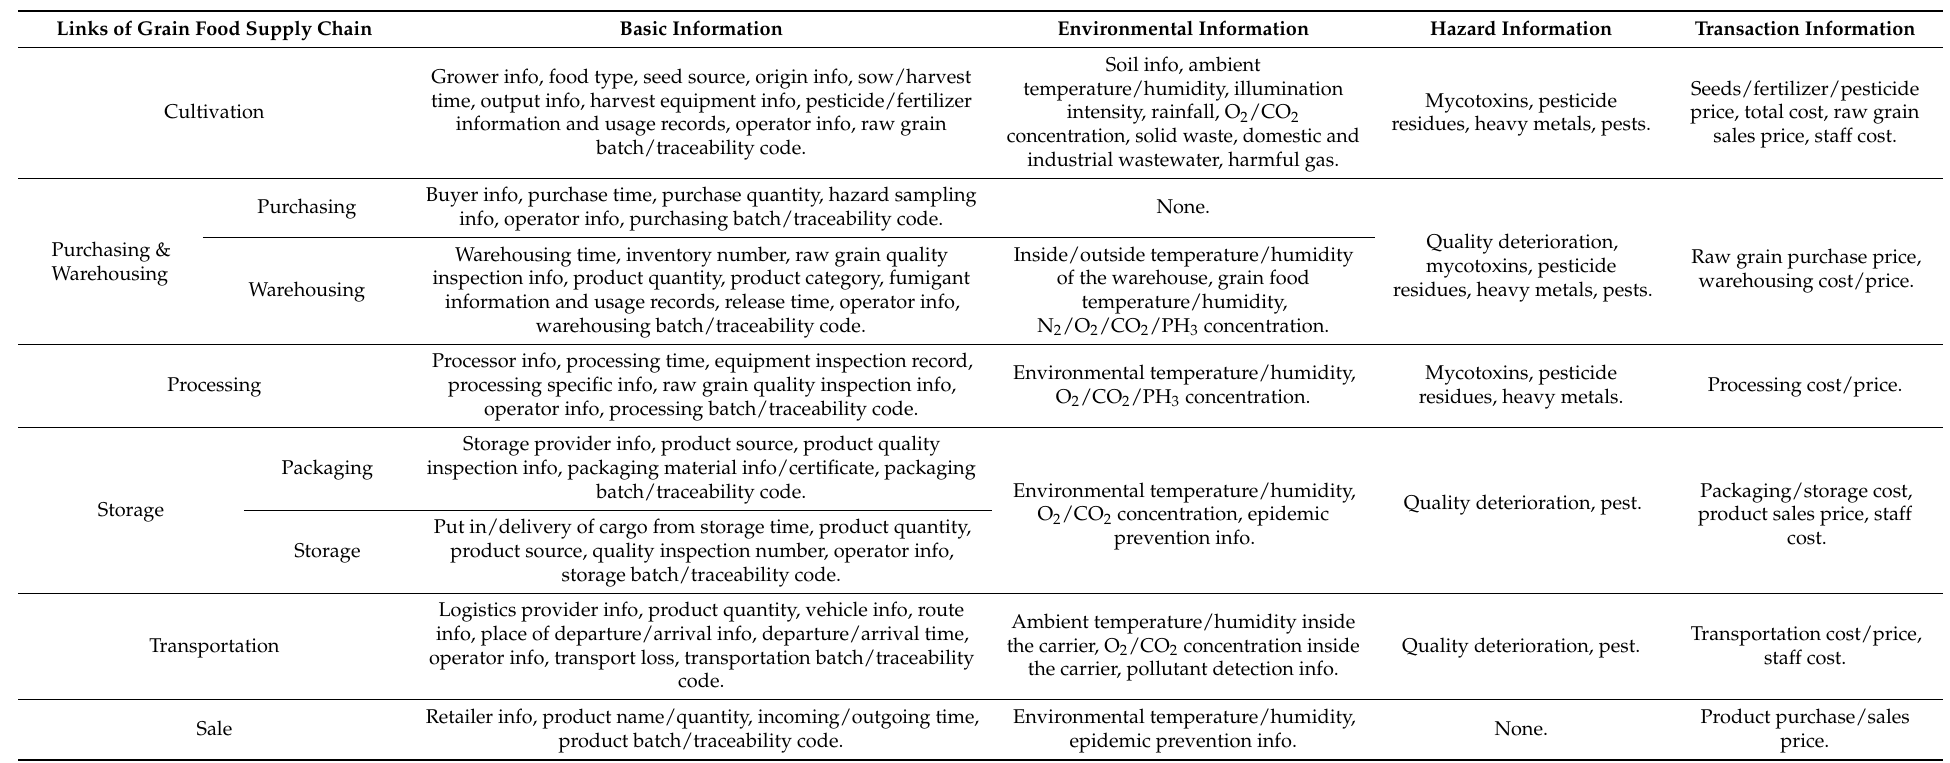
Table 1. Key information and classification of each link in the grain food supply